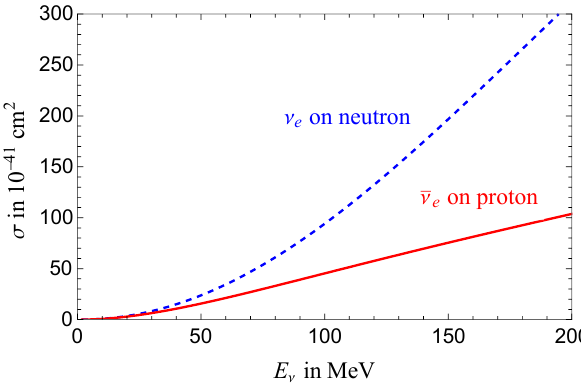
Figure 4 . Total cross sections of quasielastic scatterings at supernova neutrino